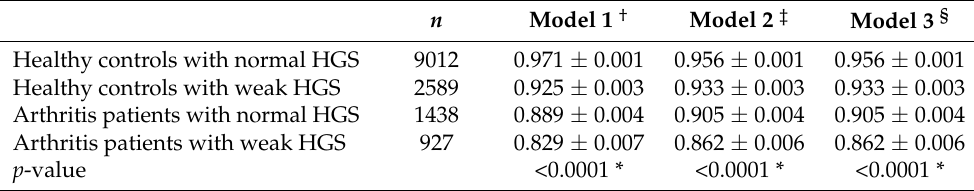
Table 3. Comparisons of EQ-5D index depending on HGS in patients with arthritis and healthy controls.